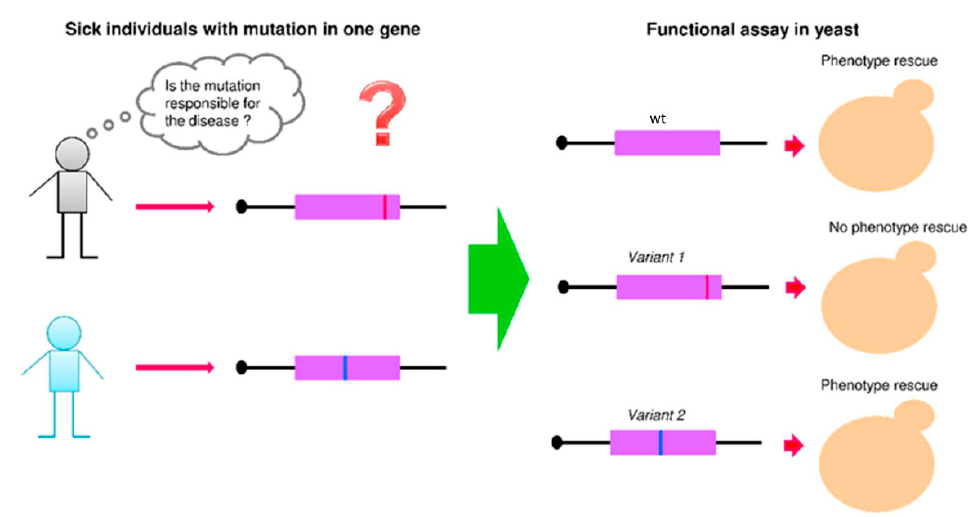
Figure 2. Schematic representation of the strategy for the characterization of variants identified in a patient. The wt and gene variants are expressed in the identified yeast strain for functional assays. Gene variants that do not rescue the phenotype are considered loss of function.